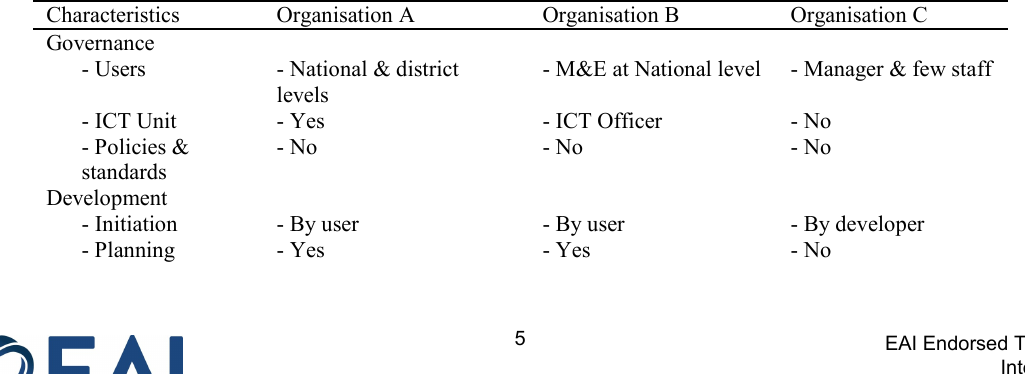
Table 2. Organisation dimension in three cases